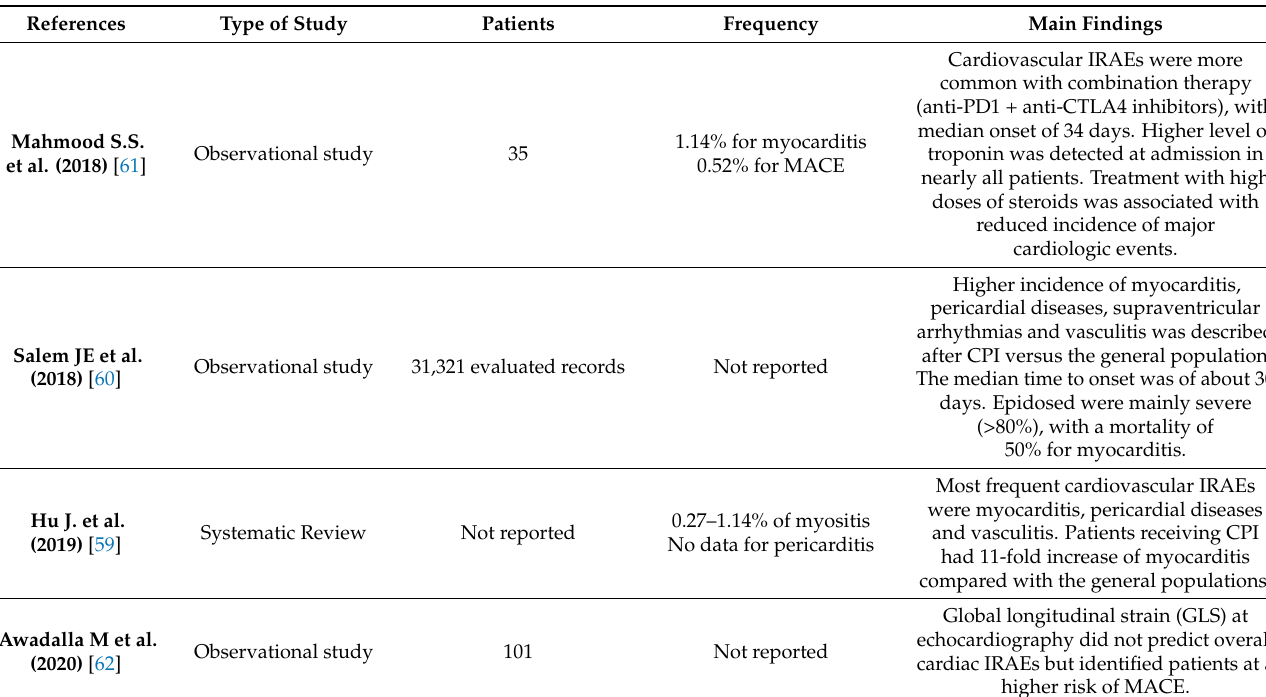
Table 7. Cardiovascular immune-related AE after checkpoint inhibitors